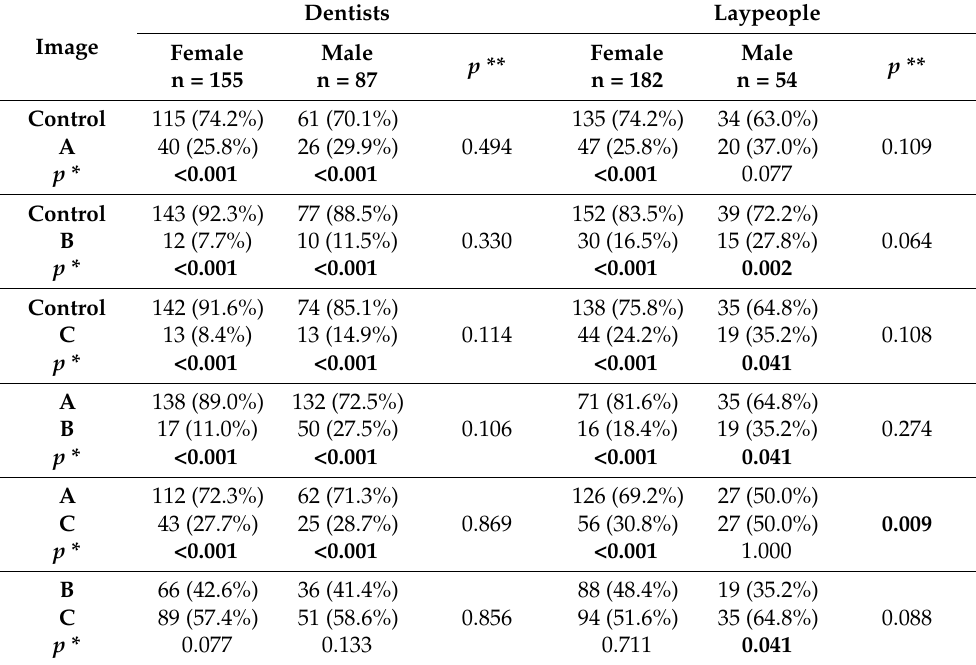
Table 2. Comparison of the perception of attractiveness in each group and by sex.